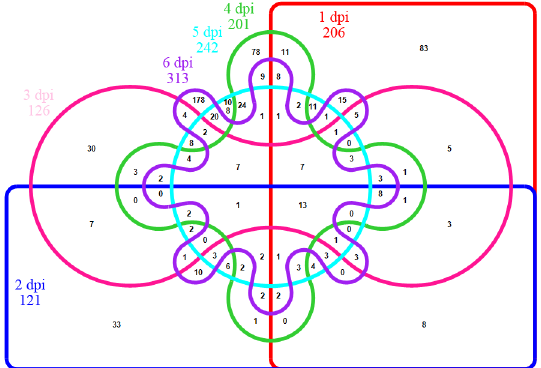
Fig 4. Six-way Venn diagram showing the distribution of shared significantly regulated host transcripts during the infection period, relative to control honey bees of the same age. Numbers of clusters are provided in the interactions. The total number of significantly regulated host transcripts is provided for each day post infection.